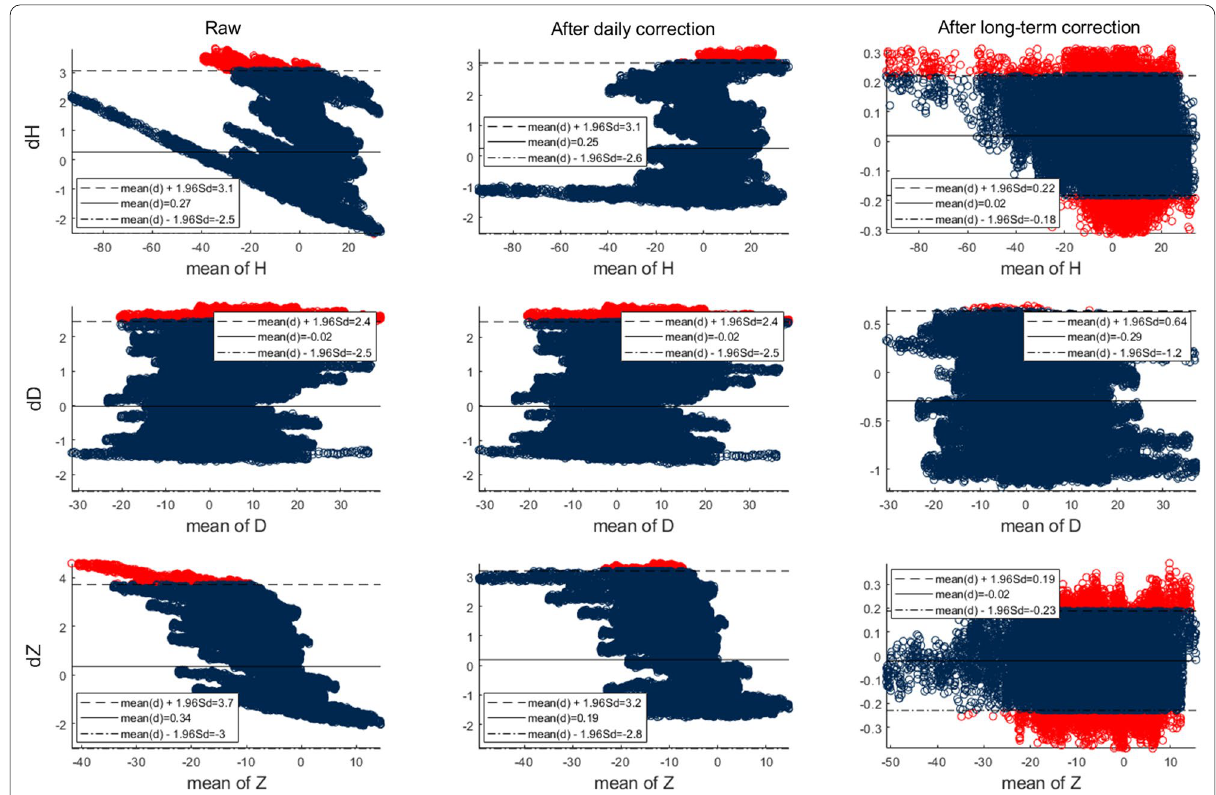
Fig. 8 B–A plots of the comparative geomagnetic vector observations during the period of January–March 2020 at